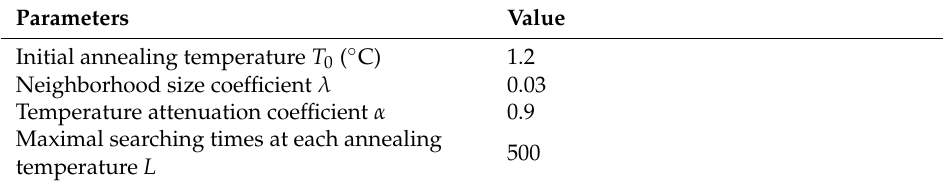
Table 5. Parameters of